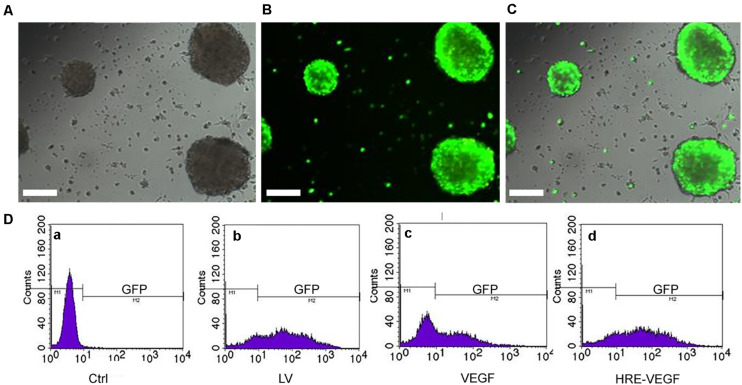
NSCs were transfected by lentiviral. (A–C) After transfection with the virus MOI for 50 by 24 h, the green fluorescence could be seen clearly under the fluorescence microscope. Scale bar: 200 μm. (D) The efficiency of transfection under flow cytometry: (a) Ctrl in normoxia: 0.49%. (b) LV: 80%. (c) VEGF transfected in normoxia: 50%. (d) HRE-VEGF transfected in hypoxia by 6, 12, and 24 h: 80%.